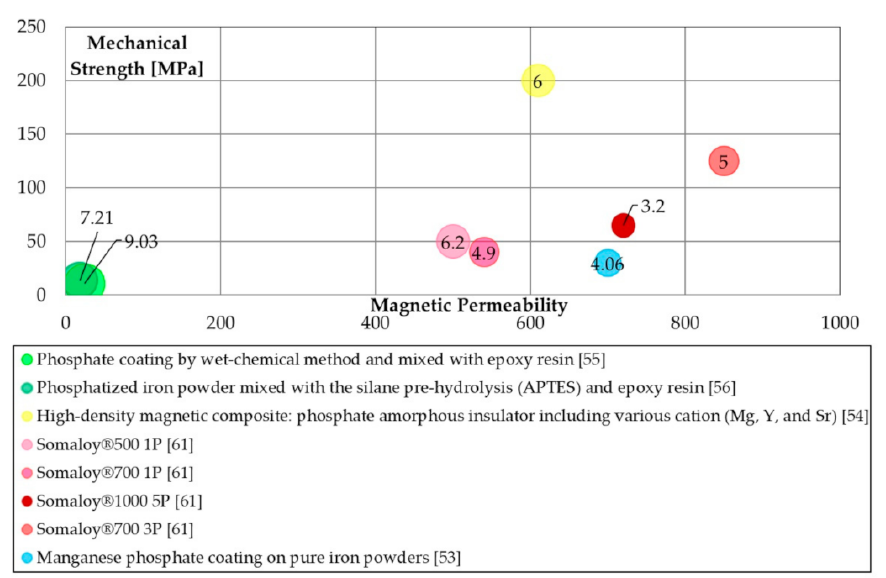
Figure 3. Magnetic (maximum permeability), mechanical (TRS [MPa]), and energetic properties (total iron losses 1 T@50 Hz [W/kg]) of phosphate coating